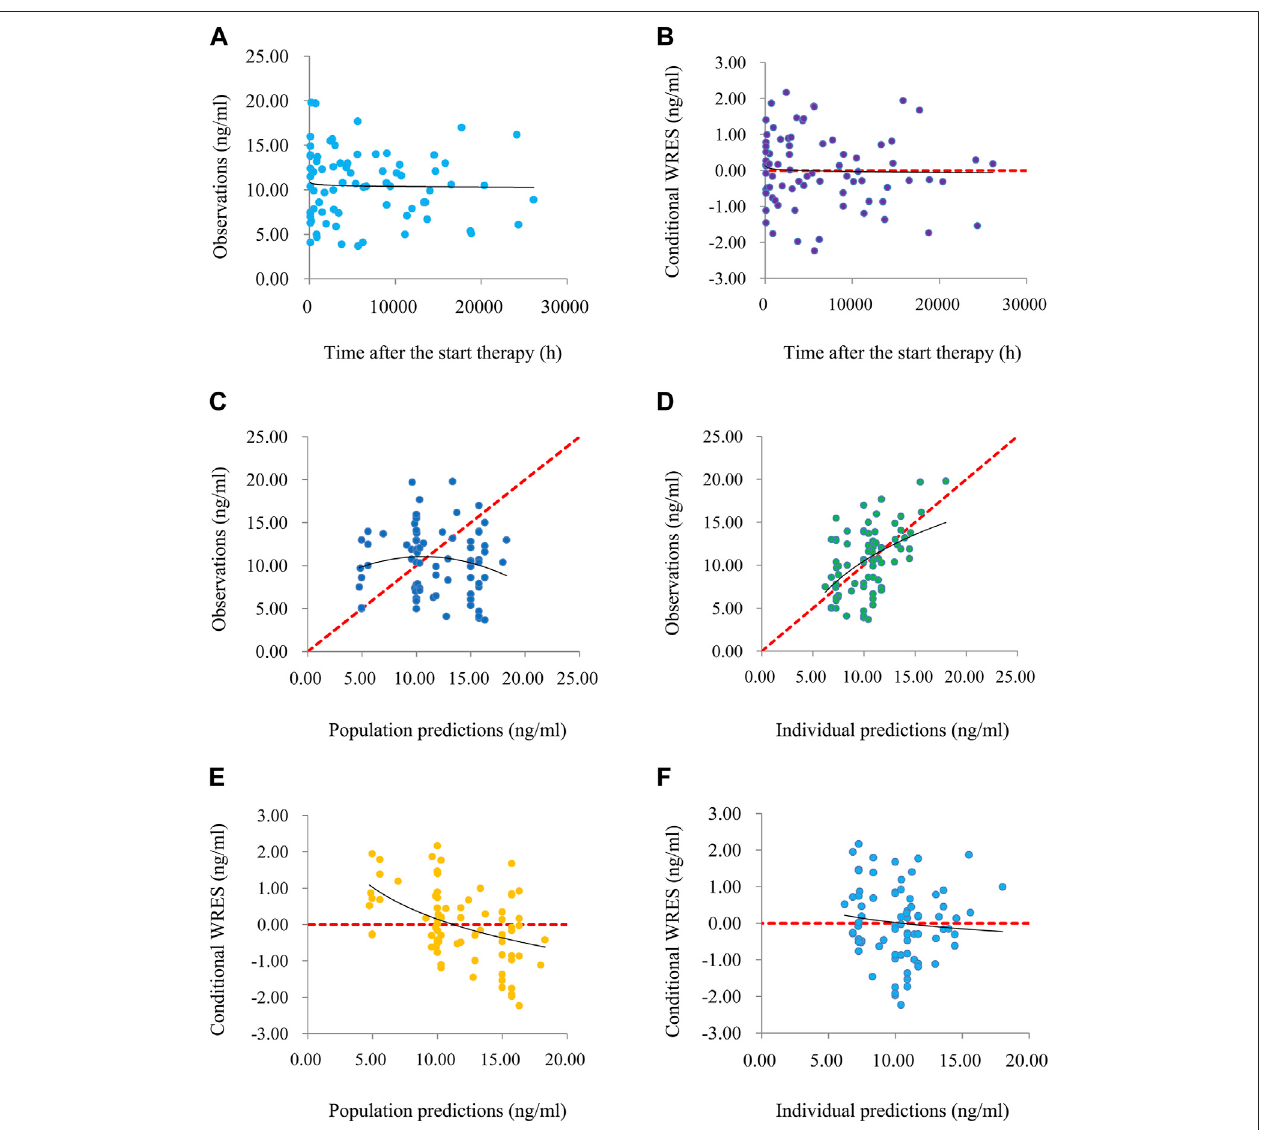
FIGURE 1 | The goodness-of- fi t plots of model. (A) Time-concentration diagram. (B) Conditional weighted residuals (WRES) vs. time after the start therapy. (C) Observations vs. population predictions. (D) Observations vs. individual predictions. (E) Conditional WRES vs. population predictions. (F) Conditional WRES vs. individual